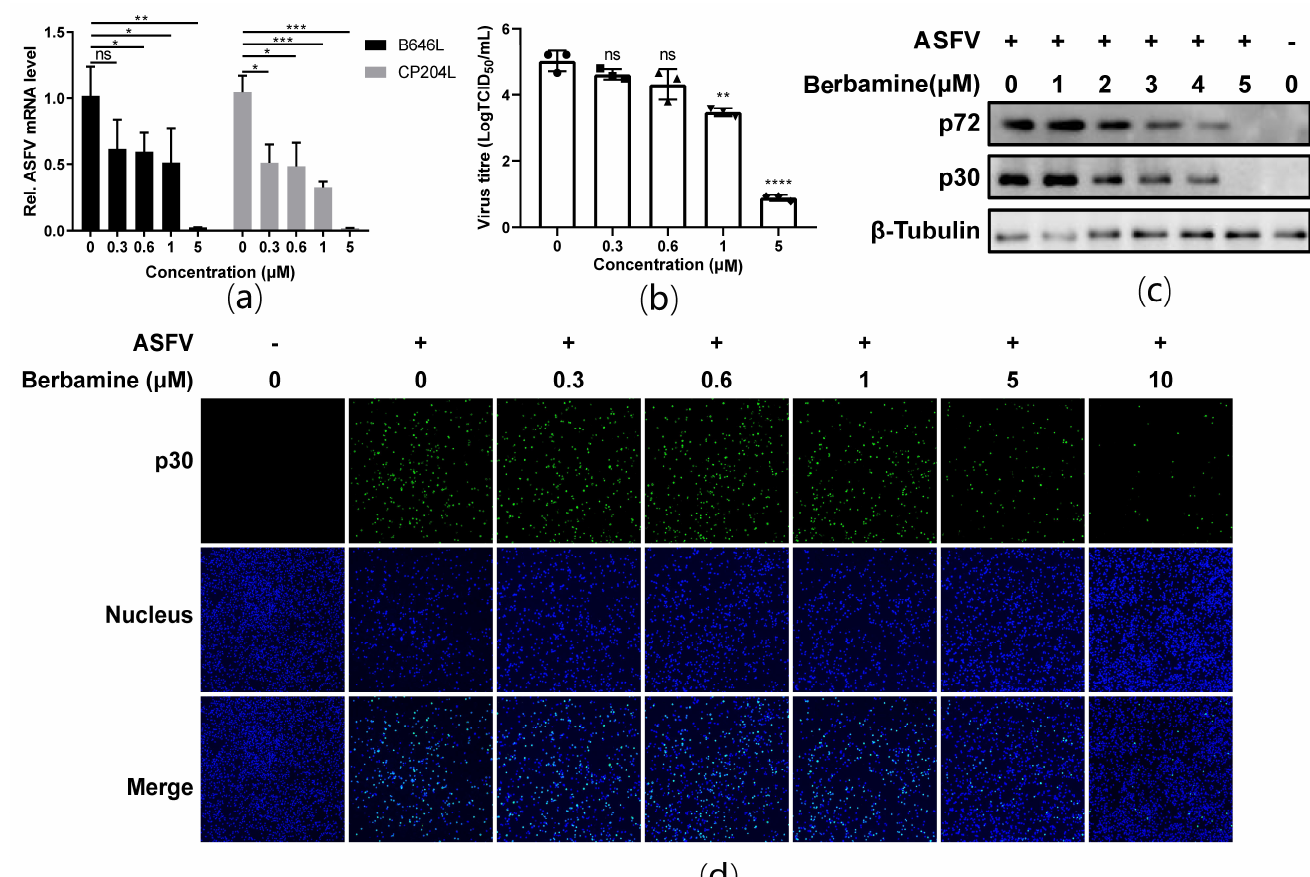
Figure 2. Antiviral activity of berbamine hydrochloride against the ASFV in PAMs. ( a ) ASFV B646L and CP204L gene transcription levels were evaluated with an RT-qPCR; ( b ) ASFV production was